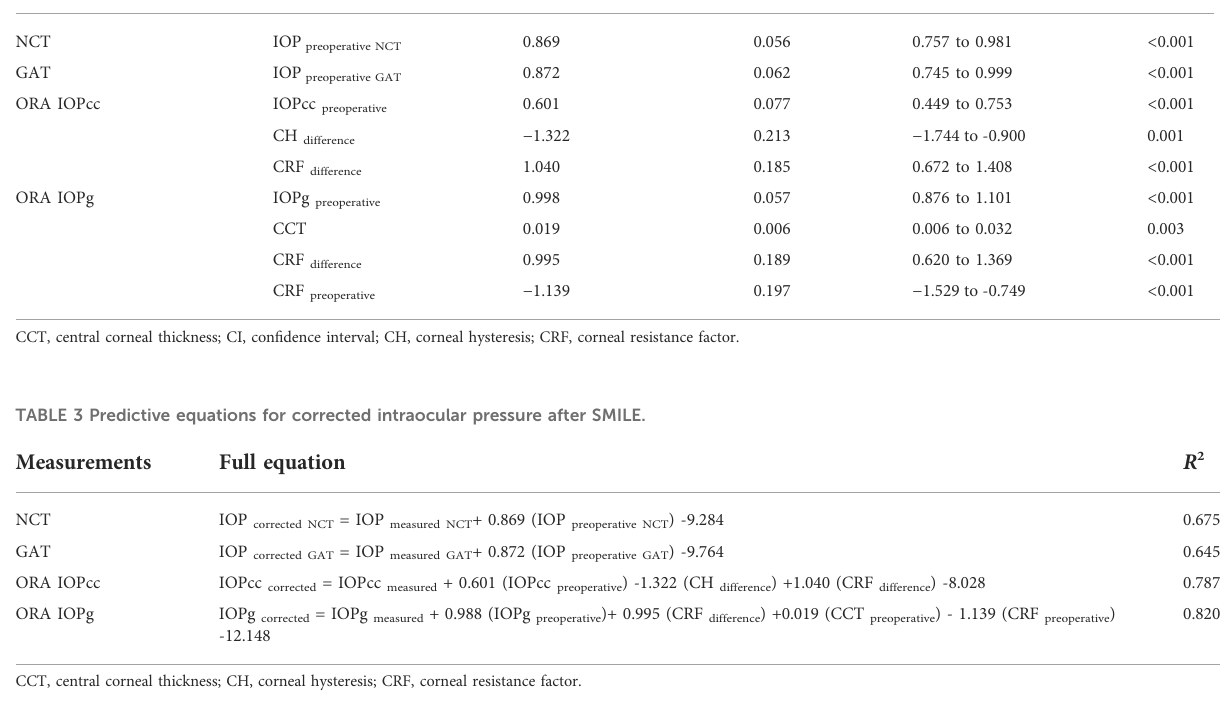
TABLE 2 Generalized linear mixed model on intraocular pressure decrease.